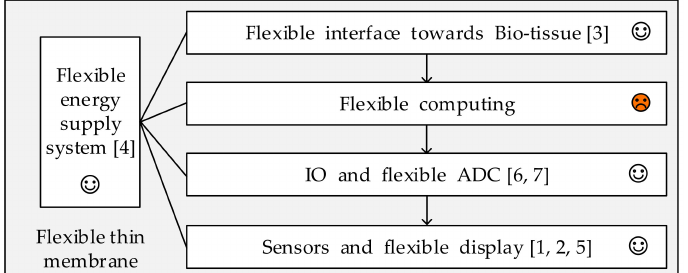
Figure 1. Innovative fully flexible